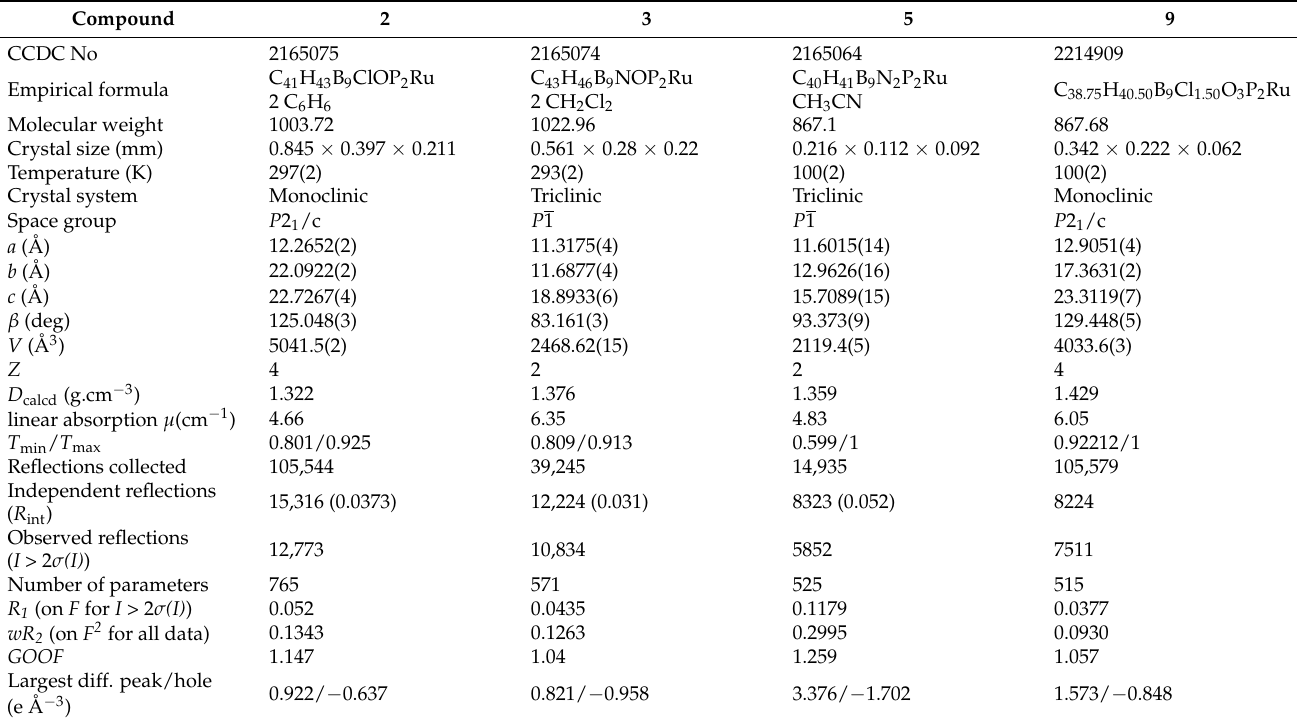
Table 5. The crystal data, data collection and structure refinement parameters for ruthenacarboranes 2 , 3 , 5